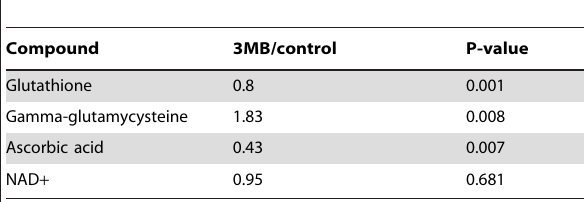
Figure S1 Used DMSO concentrations showing no impact on Arabidopsis. Representative pictures of Arabidopsis seedlings grown hydroponically for 14 days (A) or 26 days (B) with or without DMSO are shown. Figure S2 PARP inhibition is not influencing PARP or PARG expression. PARP and PARG expression shown is data [E-MTAB-1466]. The number of days (D) by which the